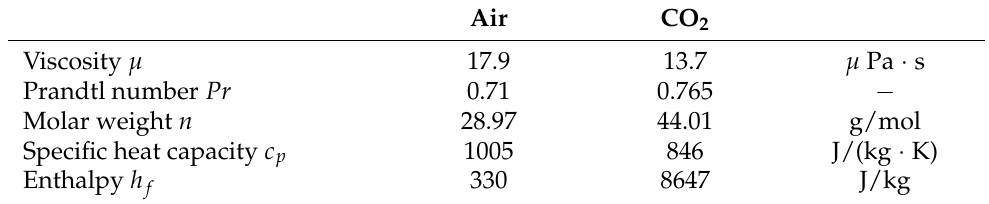
Table 1. Transport and thermodynamic parameters. All the values are given for 1 atm and 285 K.